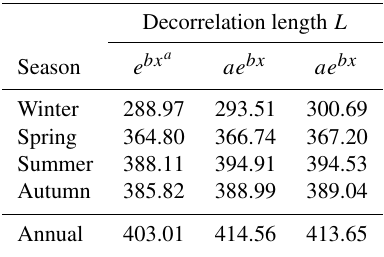
Table 3. Annual and seasonal decorrelation length L (in kilome- ters) for the three exponential functions in Fig. 4. The third column represents a fit where the point [ x , y ] = [ 0, 1 ] is added to the data points to include that the correlation = 1 when the x = 0.